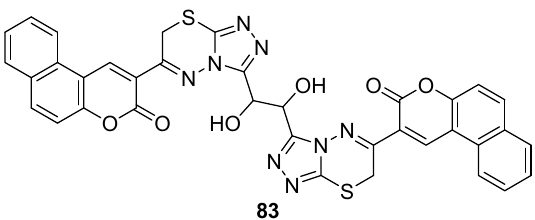
Figure 31. Bis coumarinyl bis triazolothiadiazinyl ethane derivative.